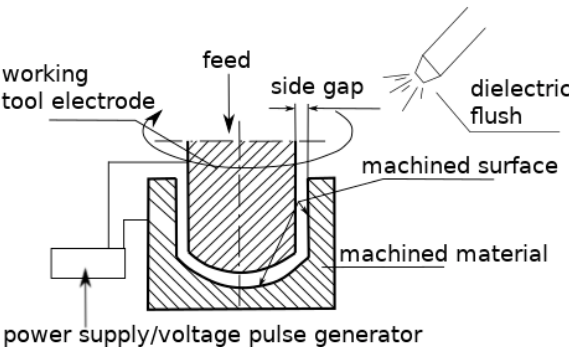
Figure 5. Scheme of the electrodischarge drilling process.